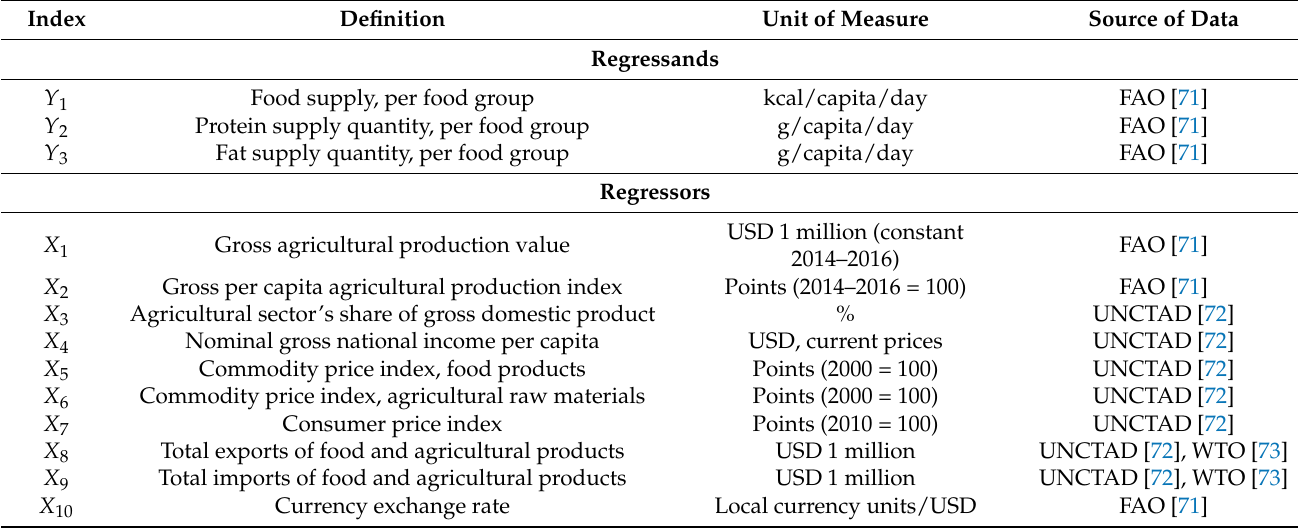
Table 2. Regressands and regressors used in the study.